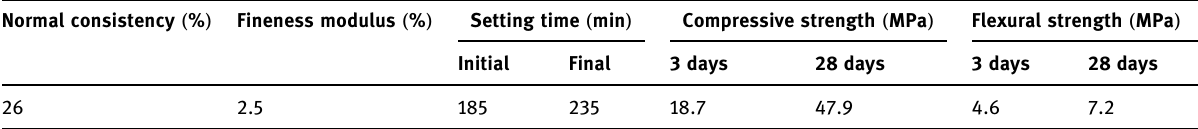
Table 1: Cement performance index Normal consistency ( % ) Fineness modulus ( % )